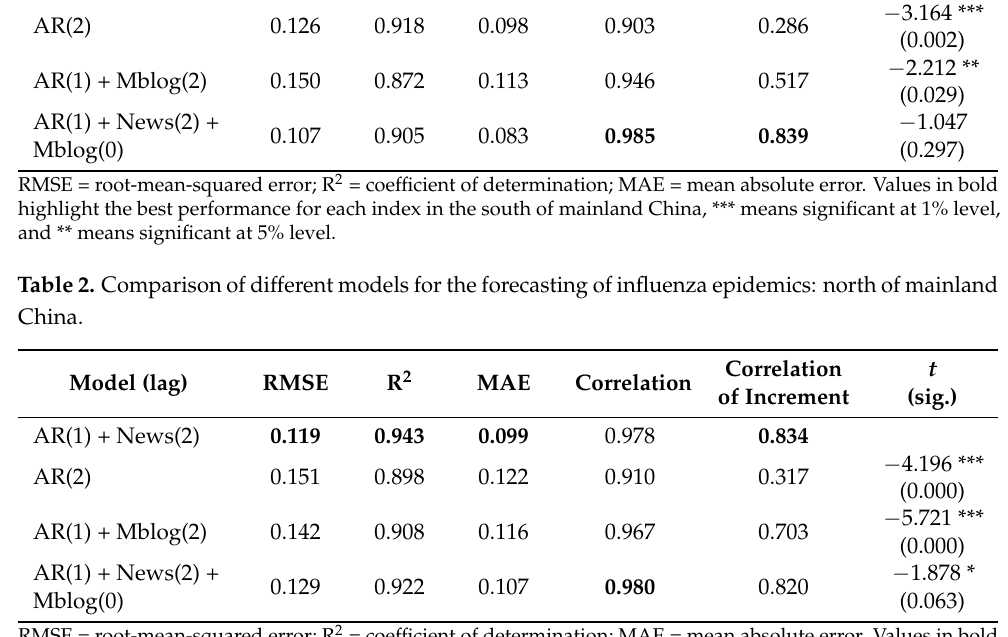
t Correlation of Increment (sig.)